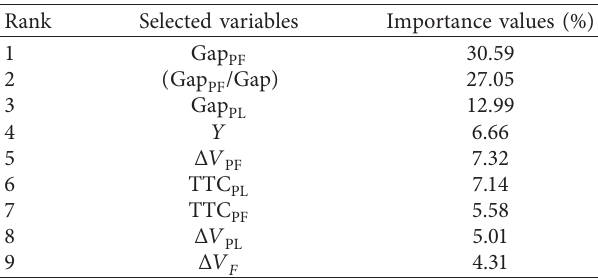
Table 7: Rank of variable importance after variable selection. Rank Selected variables Importance values (%)